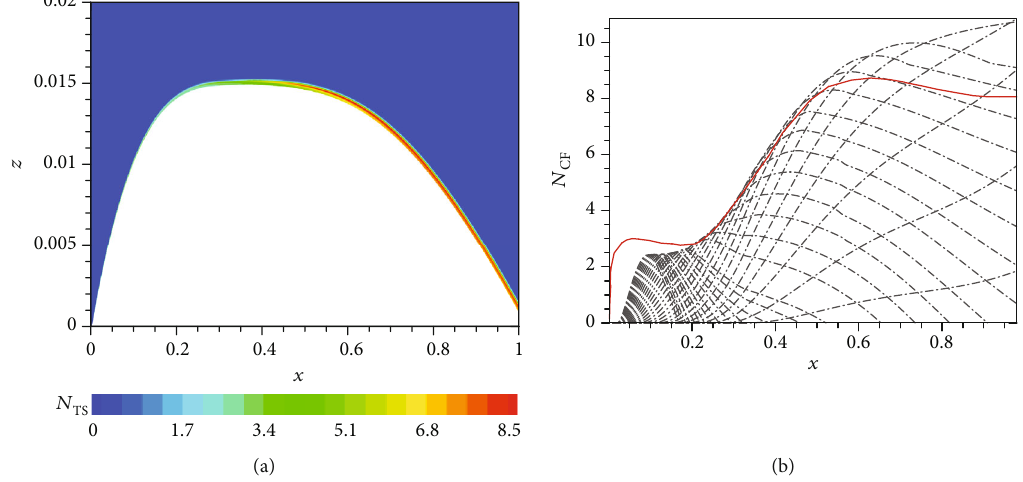
Figure 17: The predicted (a) N contour and (b) comparison with standard LST analysis results at Re = 8 : 0 × 10 7 /m . TS